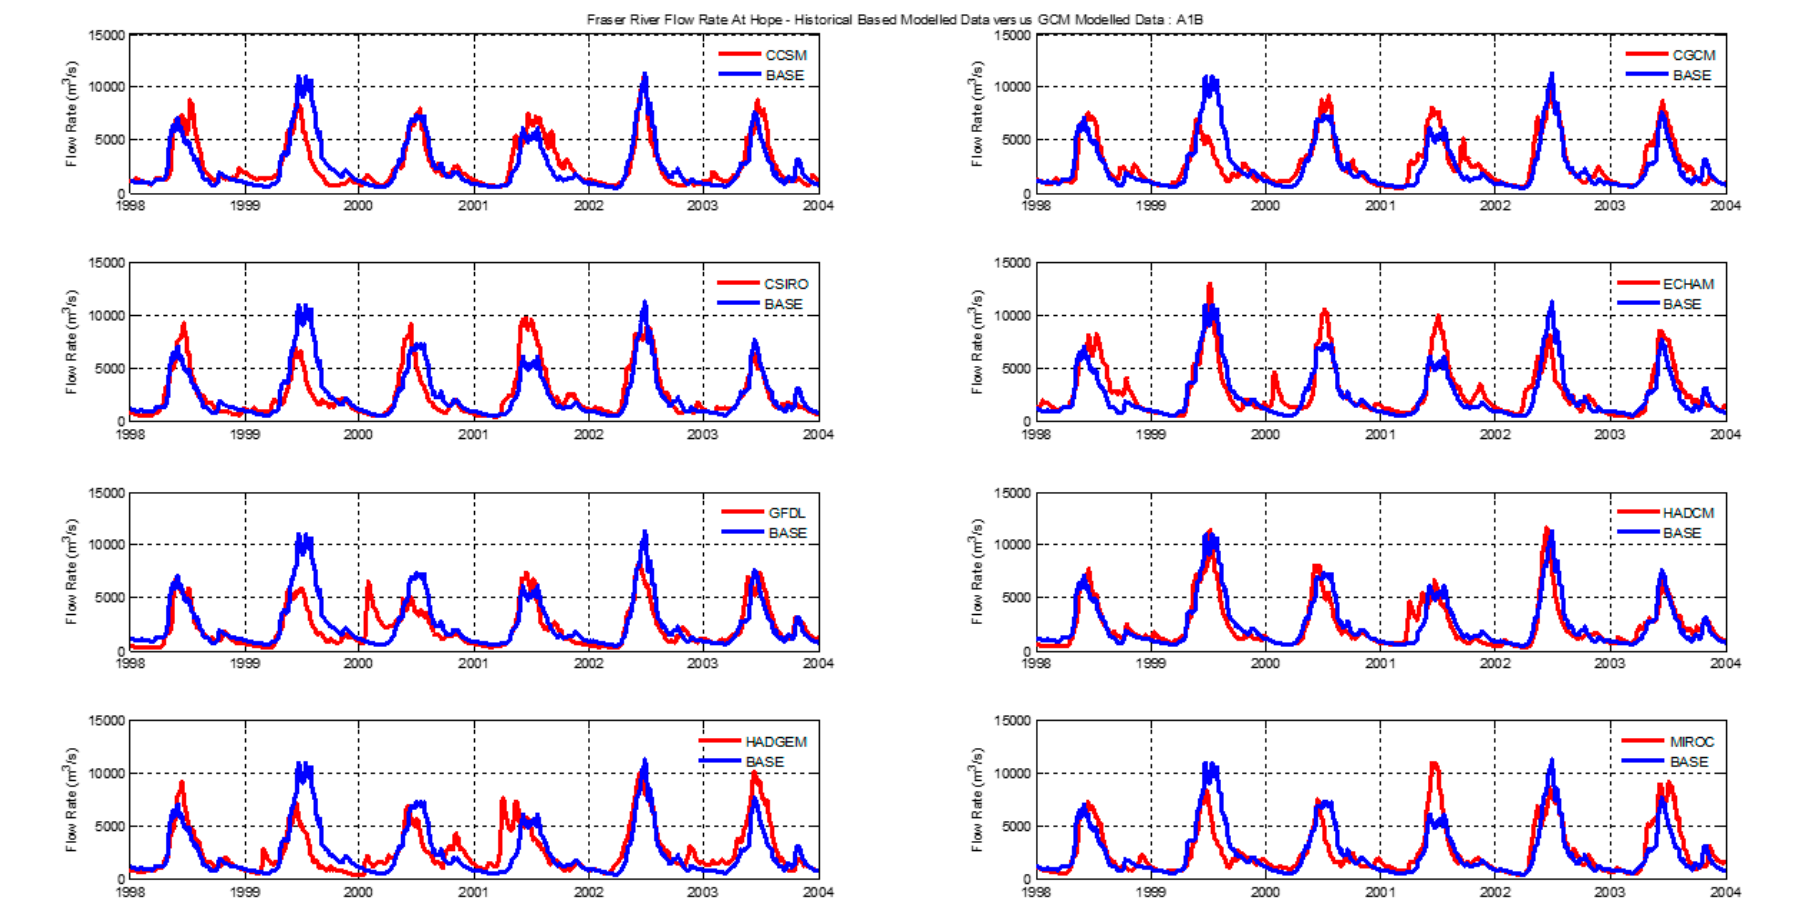
Figure 9. Comparison of observed and modelled Fraser River flow rate for years 1998–2004.